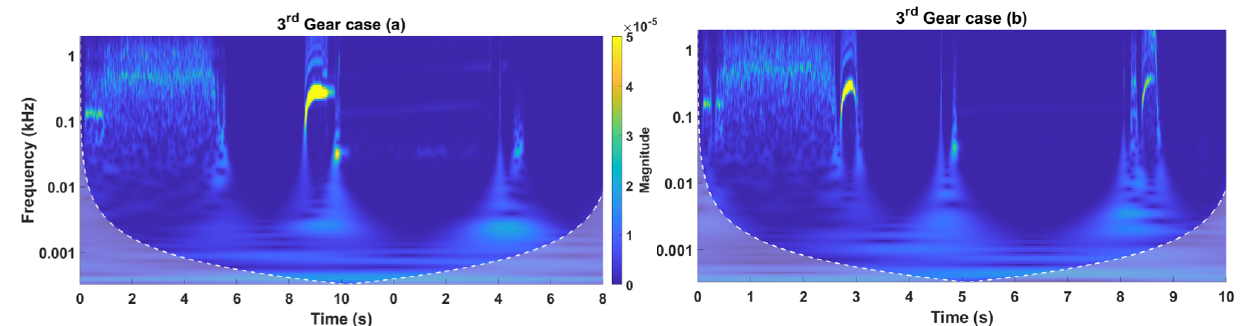
Figure 14. Time-Frequency Wavelet Transform: 3rd